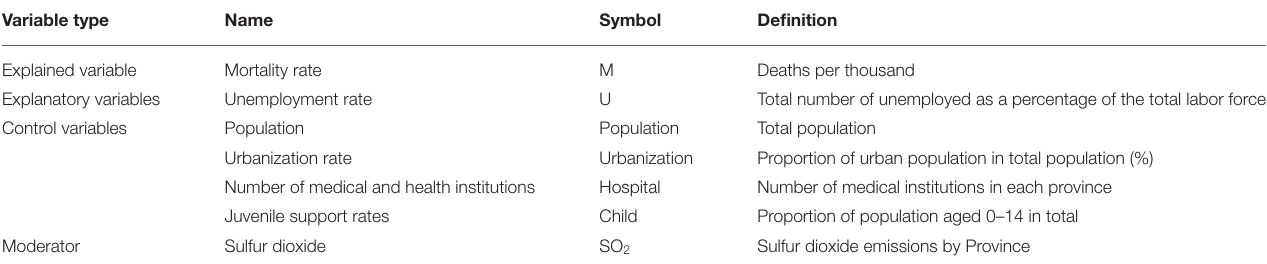
TABLE 1 | Variable definition.